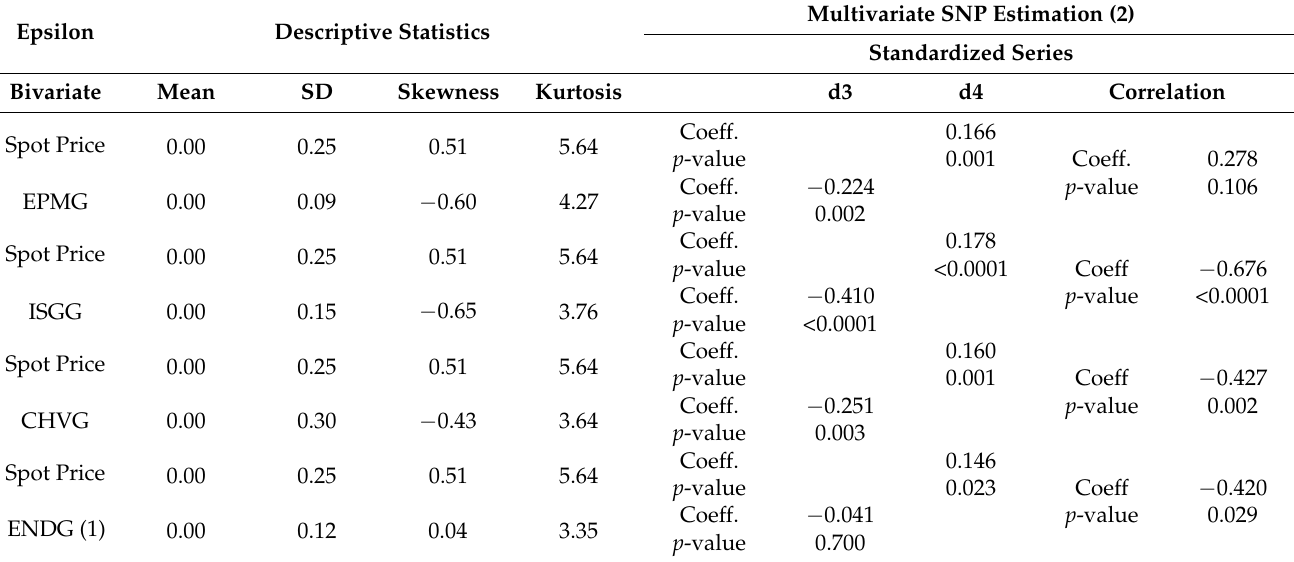
Table 4. Bivariate SNP fitted distributions of spot price and energy